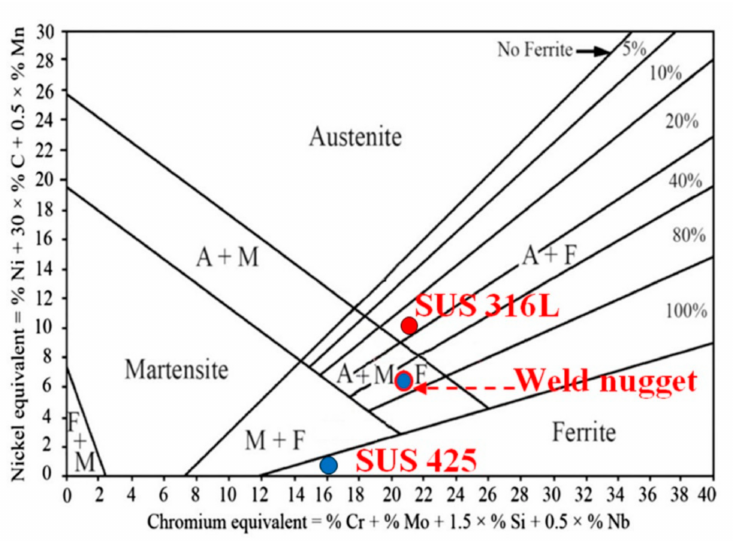
Figure 13. Schae ffl er phase